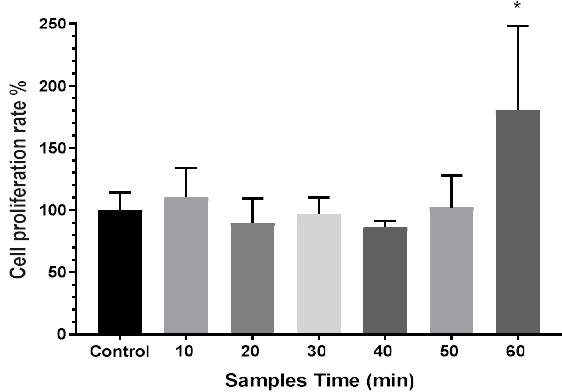
Figure 9. SW1353 cell viability determined by the presence of total LDH enzyme at different times. Results are the mean of four independent experiments performed in the DCD ± S.D. A one-way ANOVA was performed between the O.D. of each modified sample and the unmodified sample or control, where (*) ( p < 0.05).